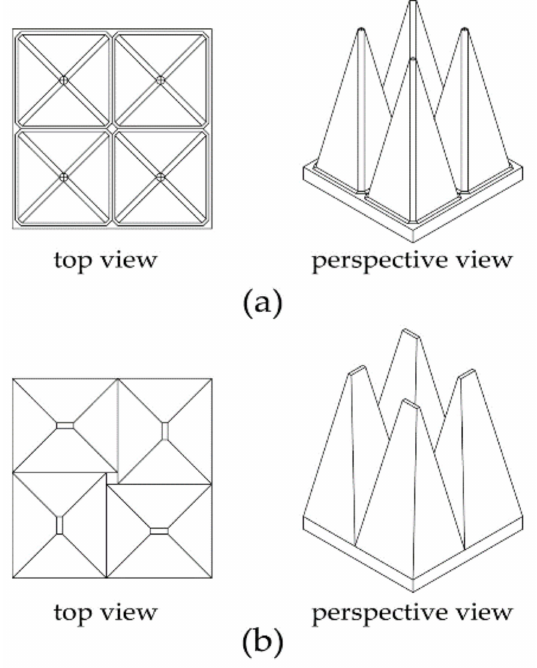
Figure 3. Electromagnetic wave absorber with cementitious matrix, containing carbon nanotubes; top view and perspective view: ( a ) sharp pyramid shape; ( b ) flat pyramid shape (after [38]). The patent [39] is for electromagnetic wave absorbing panels for use in building structures, containing an outer layer of protection plates (e.g., silicon matrix plates), an absorber layer, a reflective metal layer, and a bearing layer made of a construction material, e.g., concrete. Generalised and simplified diagrams of the patented absorber are shown in Figure 4 (adapted from [39]). A computer simulation of reflection loss versus frequency for an absorber panel whose 13 mm thick absorber layer consists of 50% polycarbonate resin and 50% of BaTiO 3 + BiFeO 3 (at the weight ratio of 1 / 3 ) is shown in Figure 5 (adapted from [39]).